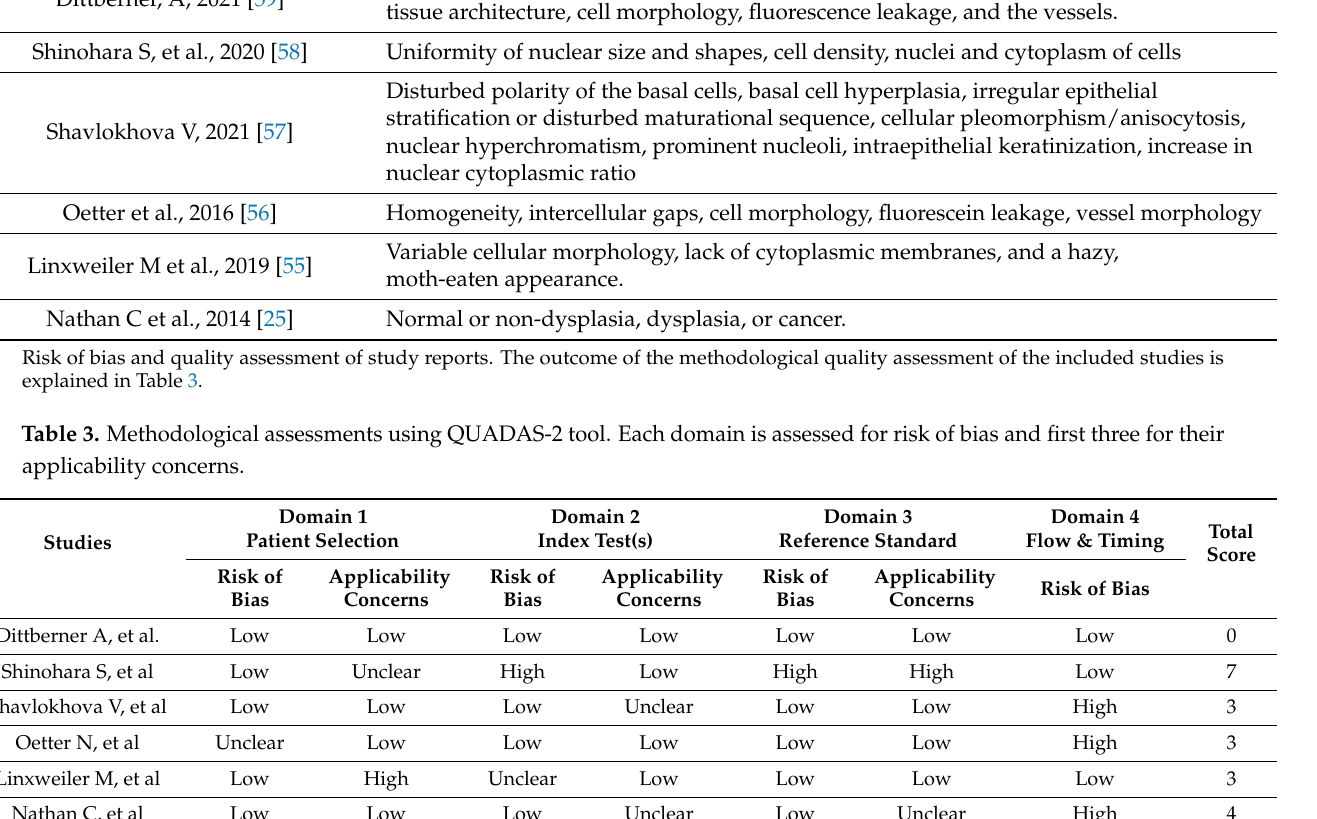
Table 2. Criteria utilised for diagnosis of oral squamous cell carcinoma by the studies included in this review. Author, Year, [Reference] Laser Confocal Endoscopy Microscopic Criteria Dittberner, A, 2021 [59]